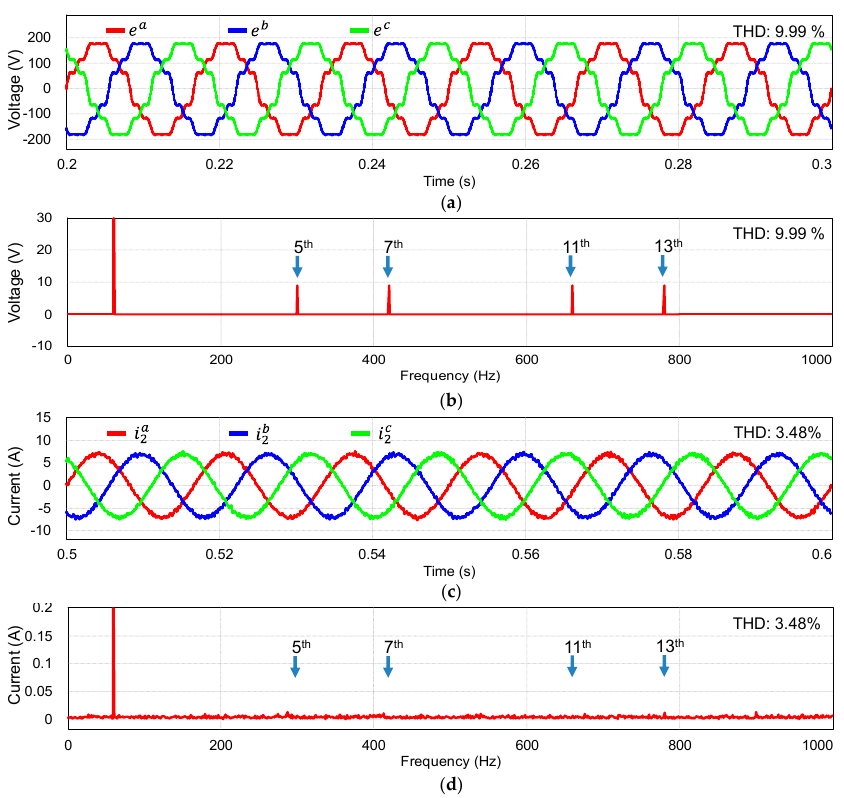
Figure 6. Simulation results of the proposed controller under three-phase distorted grid voltages. ( a ) Three-phase grid voltages; ( b ) FFT result of phase- a voltage; ( c ) three-phase grid currents; and ( d ) FFT result of phase- a current.